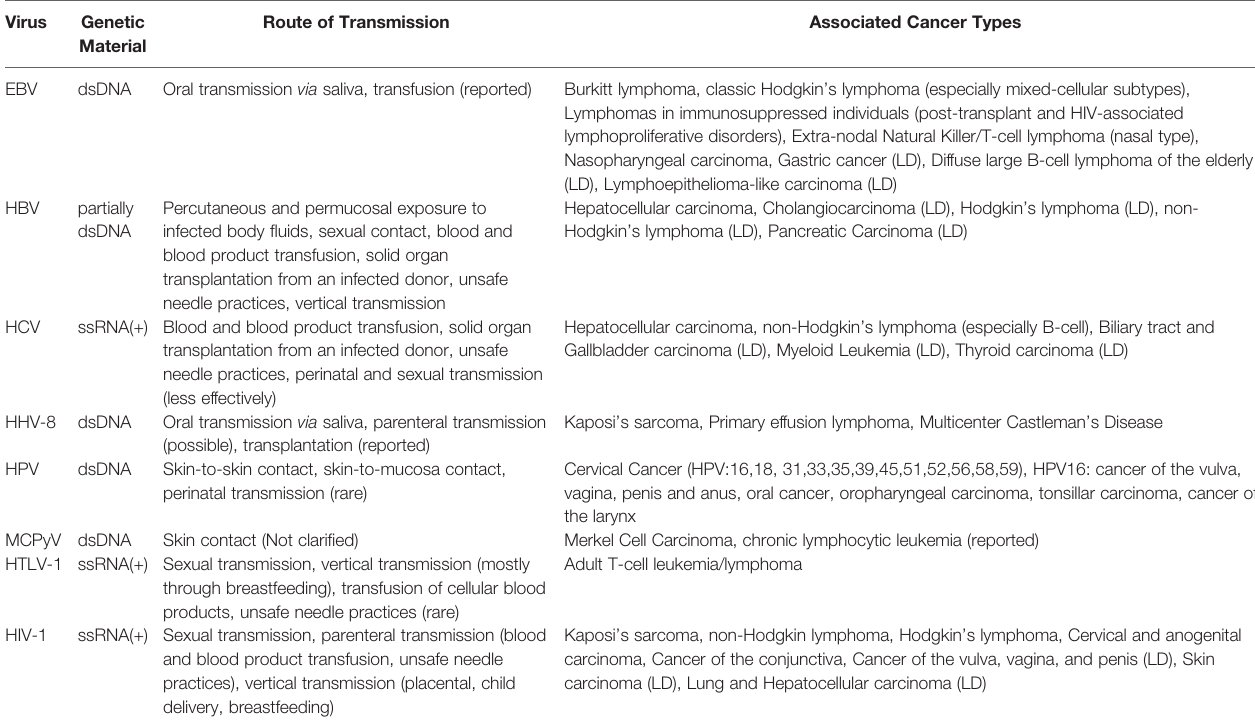
TABLE 1 | Summary of the viruses classi fi ed as Group 1 carcinogens for humans according to the IARC, route of transmission and associated malignancies. Virus Genetic Route of Transmission Associated Cancer Material